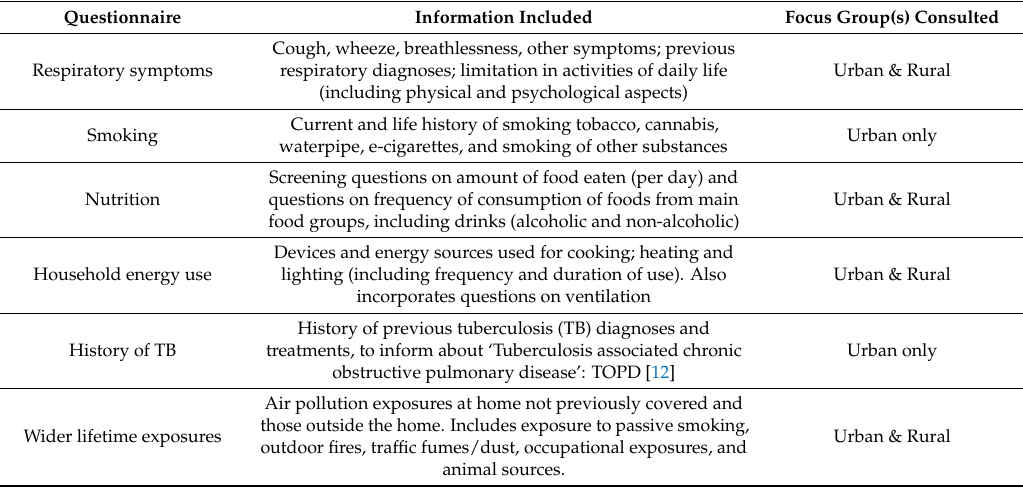
Table 1. Questionnaires included in the final